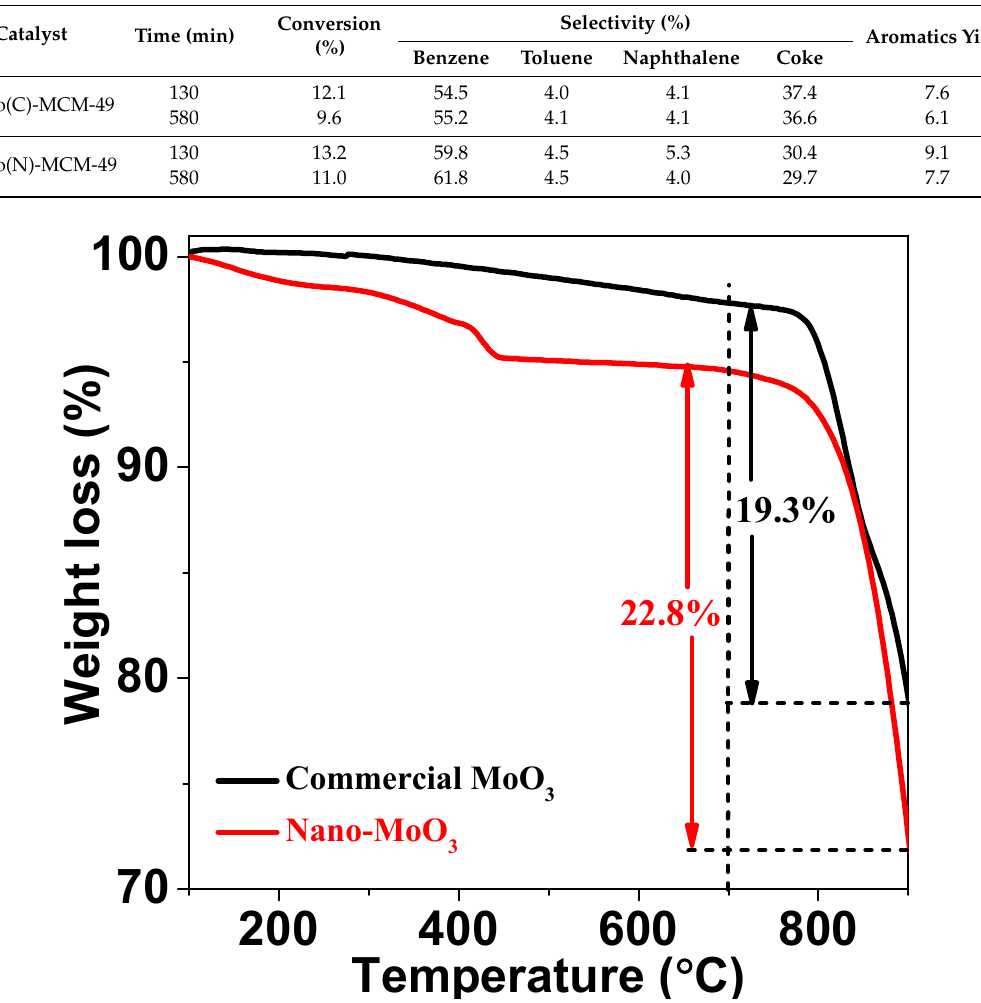
Figure 3. Thermogravimetric analysis of commercial MoO 3 and ano-MoO 3 .